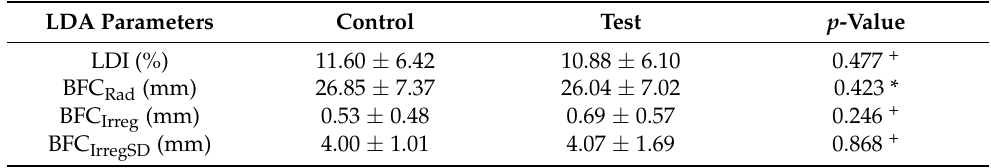
Table 4. Mean ± standard deviation of the four parameters measured for light disturbance analysis, for both control and test conditions. The symbol * marks the p -value obtained with the paired samples t -test, contrary to the others obtained with the Wilcoxon test. LDA Parameters Control Test p -Value LDI (%) 11.60 ± 6.42 10.88 ± 6.10 0.477 + BFC Rad (mm) 26.85 ± 7.37 26.04 ± 7.02 0.423 * BFC Irreg (mm) 0.53 ± 0.48 0.69 ± 0.57 0.246 + BFC IrregSD (mm) 4.00 ± 1.01 0.868